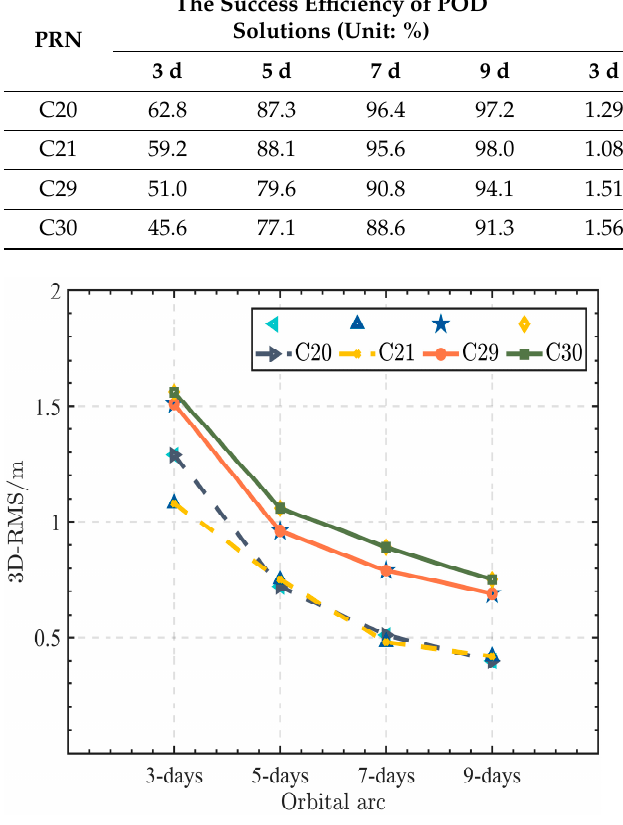
Table 5. The success efficiency and average 3D-RMS of SLR-only PODs. PRN